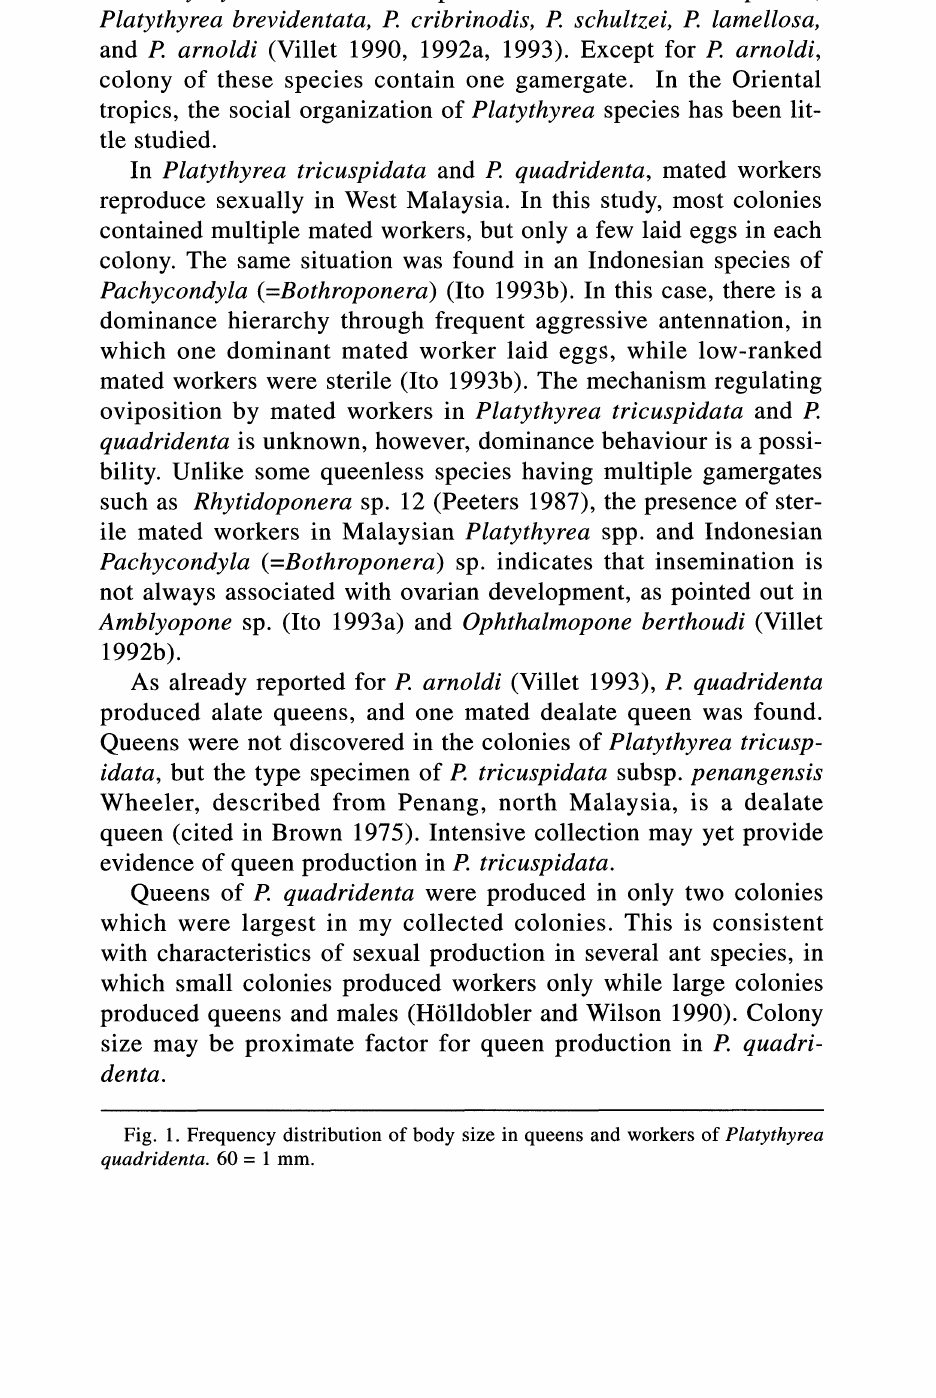
Fig. 1. Frequency distribution of body size in queens and workers of Platythyrea quadridenta. 60